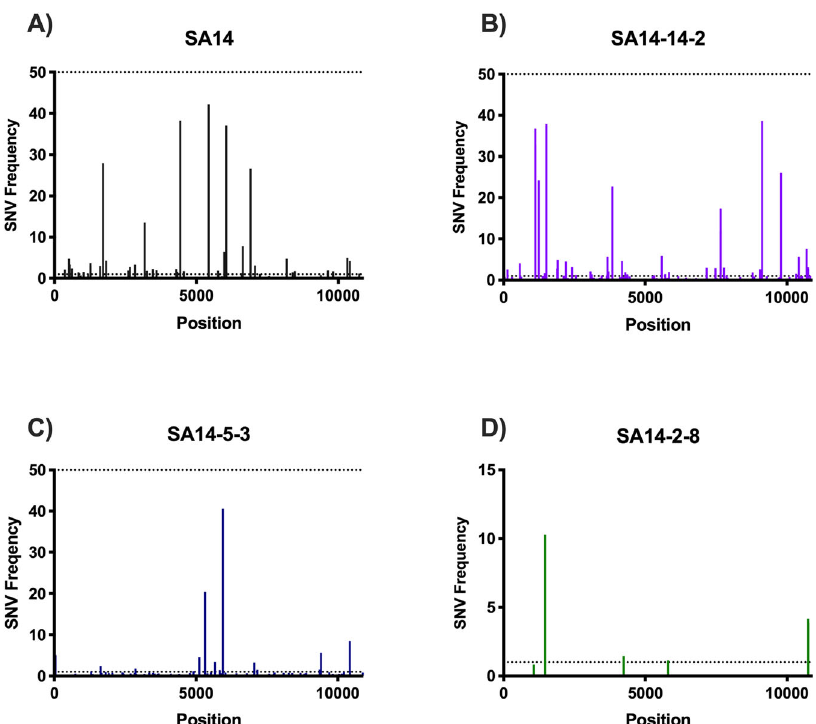
Fig. 5 Frequency and genome location of single nucleotide variants detected in SA14 and vaccine derivatives. RNA was extracted and sequenced using Illumina methods. LoFreq software was used to detect SNVs in SA14 ( A ), SA14-14-2 ( B ), SA14-5-3 ( C ) and SA14-2-8 ( D ) samples. Dotted lines represent 50% of the population at which an SNV would become the consensus nucleotide and 1% of the population. An SNV frequency cutoff was applied at 0.05% frequency.